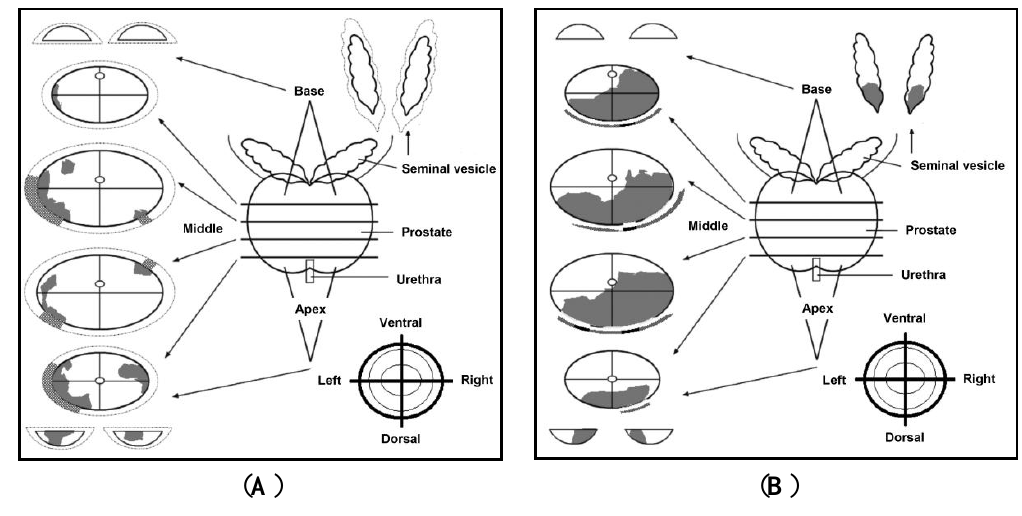
Figure 5. Institutional routine pathology report. The documents contain cross-sectional views of radical prostatectomy specimens showing areas of adenocarcinoma in the prostate pathological